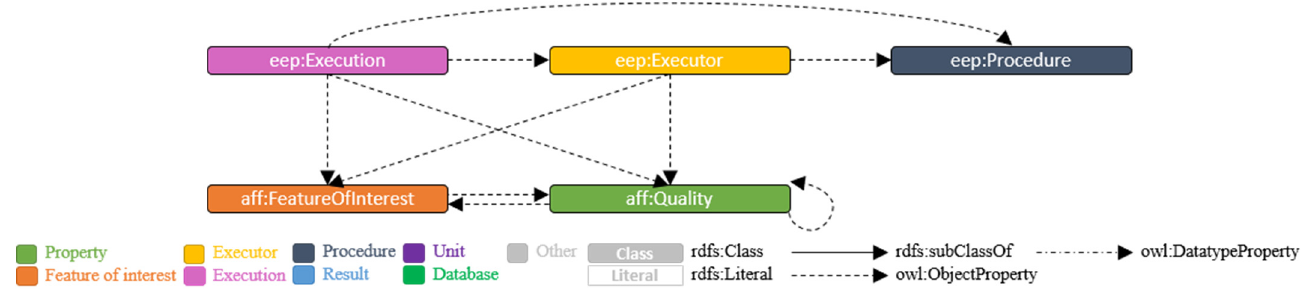
Figure 7. Generalization and improvement of SSN/SOSA, SSO, and AAE using the EEP ontology. Hu et al. [44] created the TDO ontology for tunnel diagnosis (Figure 8). The